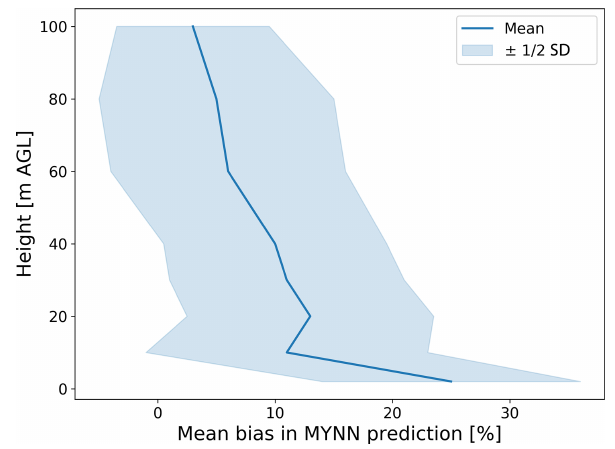
Figure 5. Bias in the MYNN-parameterized log ((cid:15)) at different heights, as calculated from the 184 sonic anemometers at